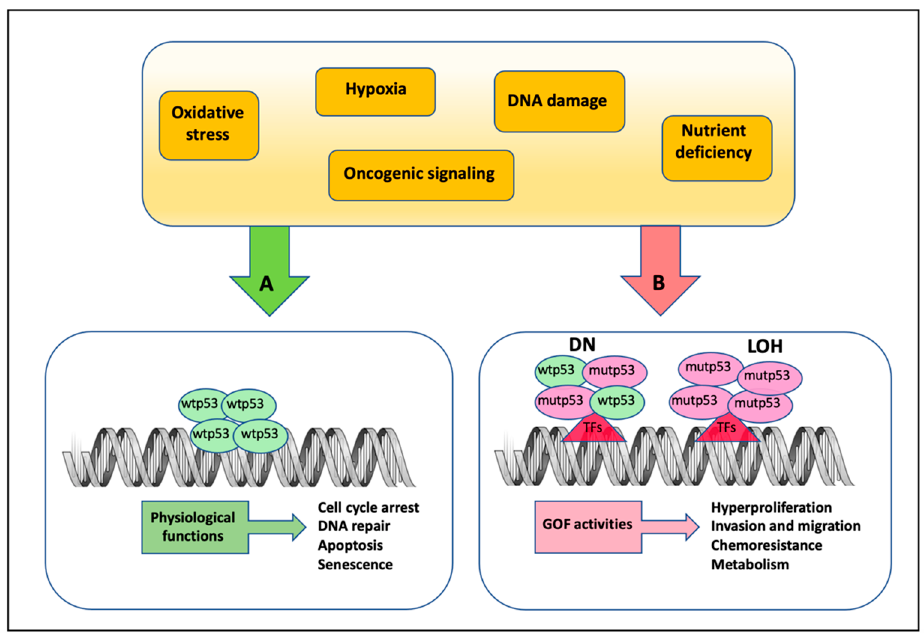
Figure 2. Mechanisms of action of wild-type and mutant p53 protein in response to different stresses. ( A ) In response to diverse types of cellular stress signals, the wild-type p53 protein is induced to activate different pathways by its recruitment onto specific DNA consensus sequences of target gene promoters. ( B ) On the other side, mutant p53 forms oncogenic complexes with other transcription factors, usually not bound by wild-type p53, resulting in the aberrant activation of genes that promote GOF activities. Notably, when TP53 mutations occur in one of the alleles, mutant p53 co-exists with wtp53 acting as a dominant negative (DN) factor in the heterodimer complexes, until the loss of the wild-type allele by loss-of-heterozygozity (LOH). The TP53 gene appears to be mutated in about 50% of all human cancers. About 80% of these mutations are missense and produce a full-length, very stable protein that tends